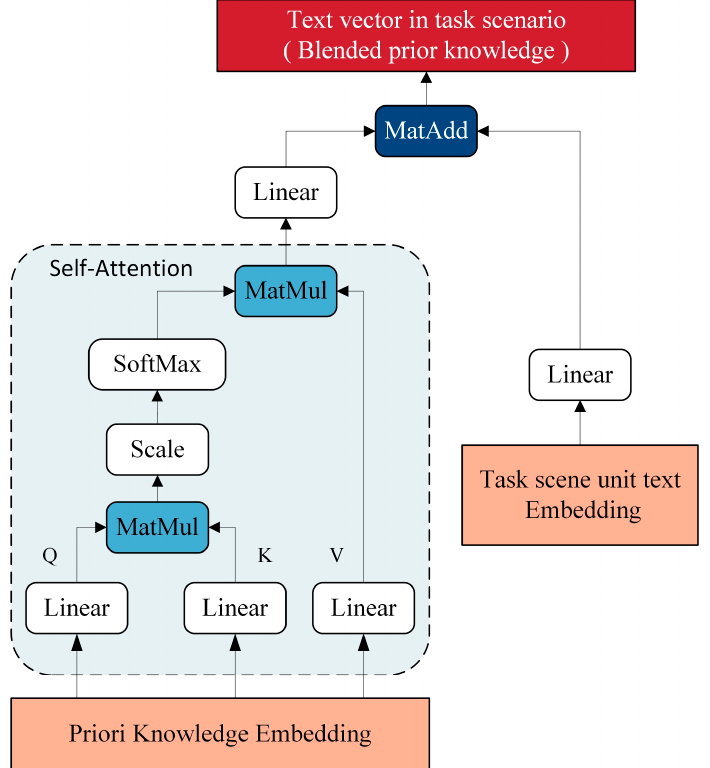
Figure 1. Structure of the a priori a tt ention model.